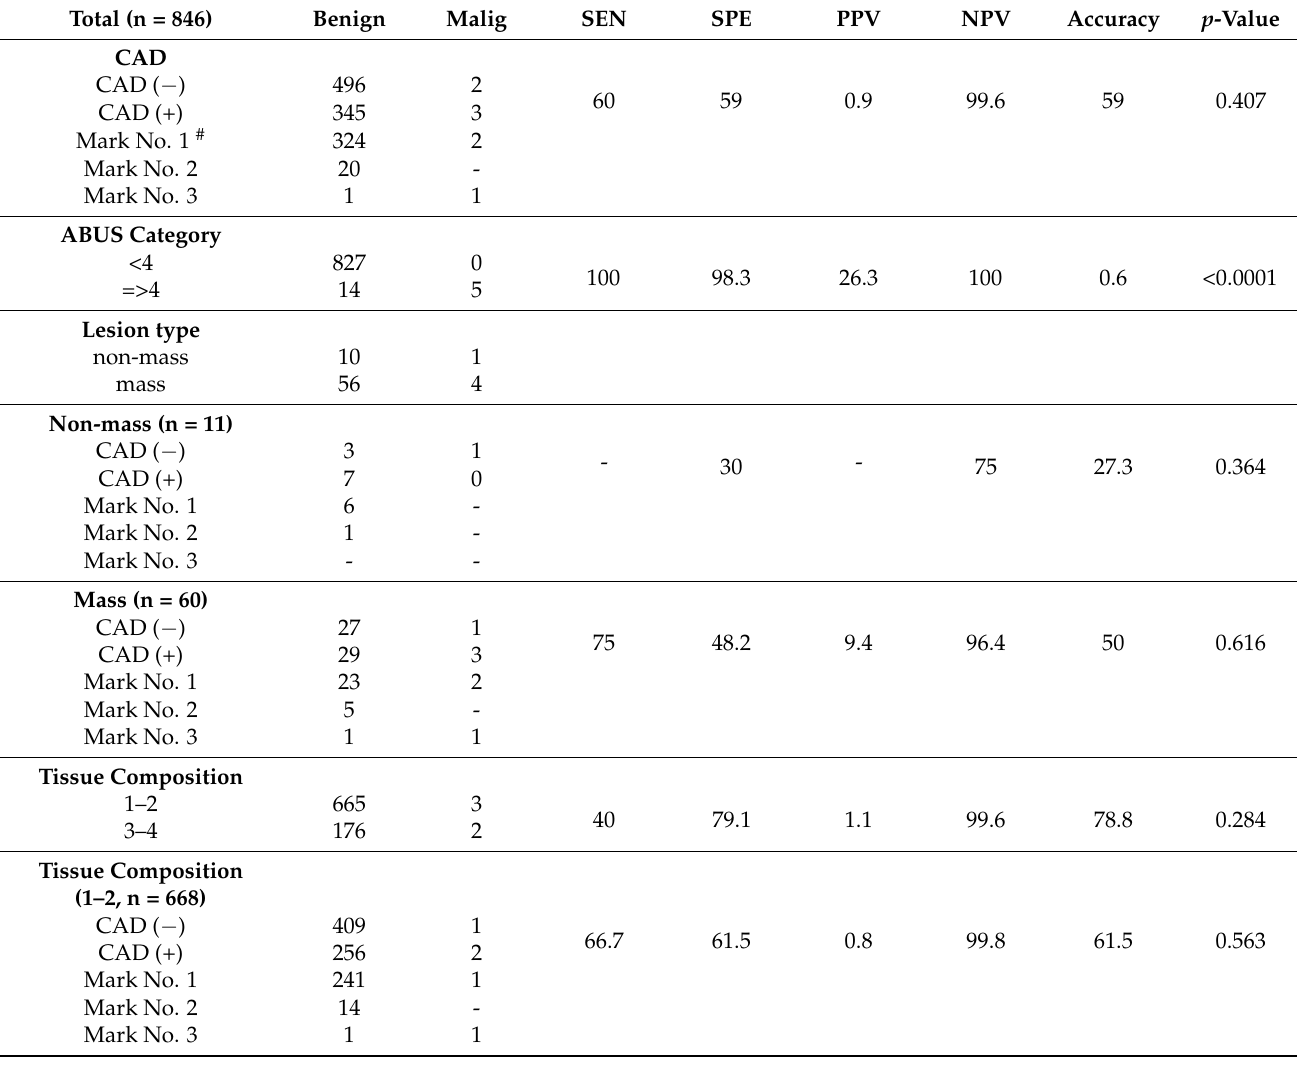
Table 1. Sensitivity (SEN), specificity (SPE), positive predictive value (PPV), negative predictive value (NPV), and accuracy per patient and per computer aided detection (CAD)